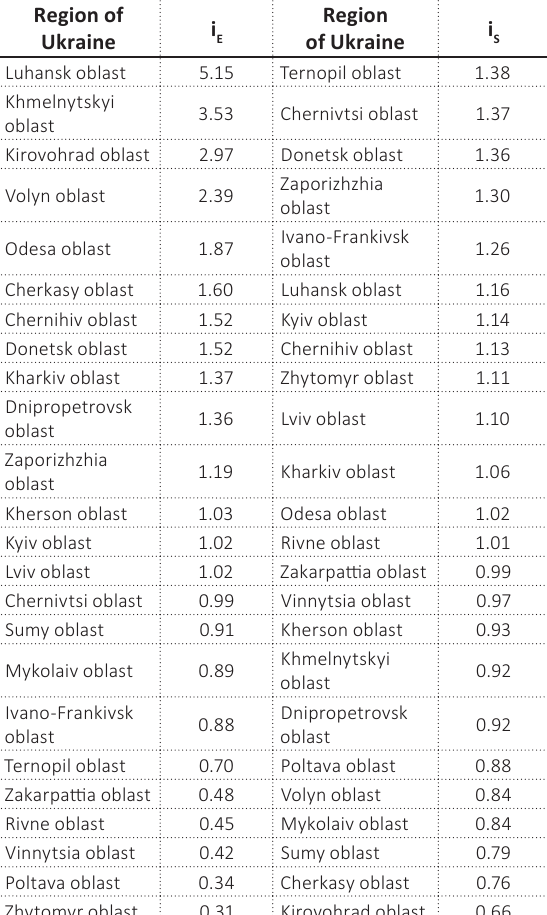
Table 8. Results of calculating dynamic indices i